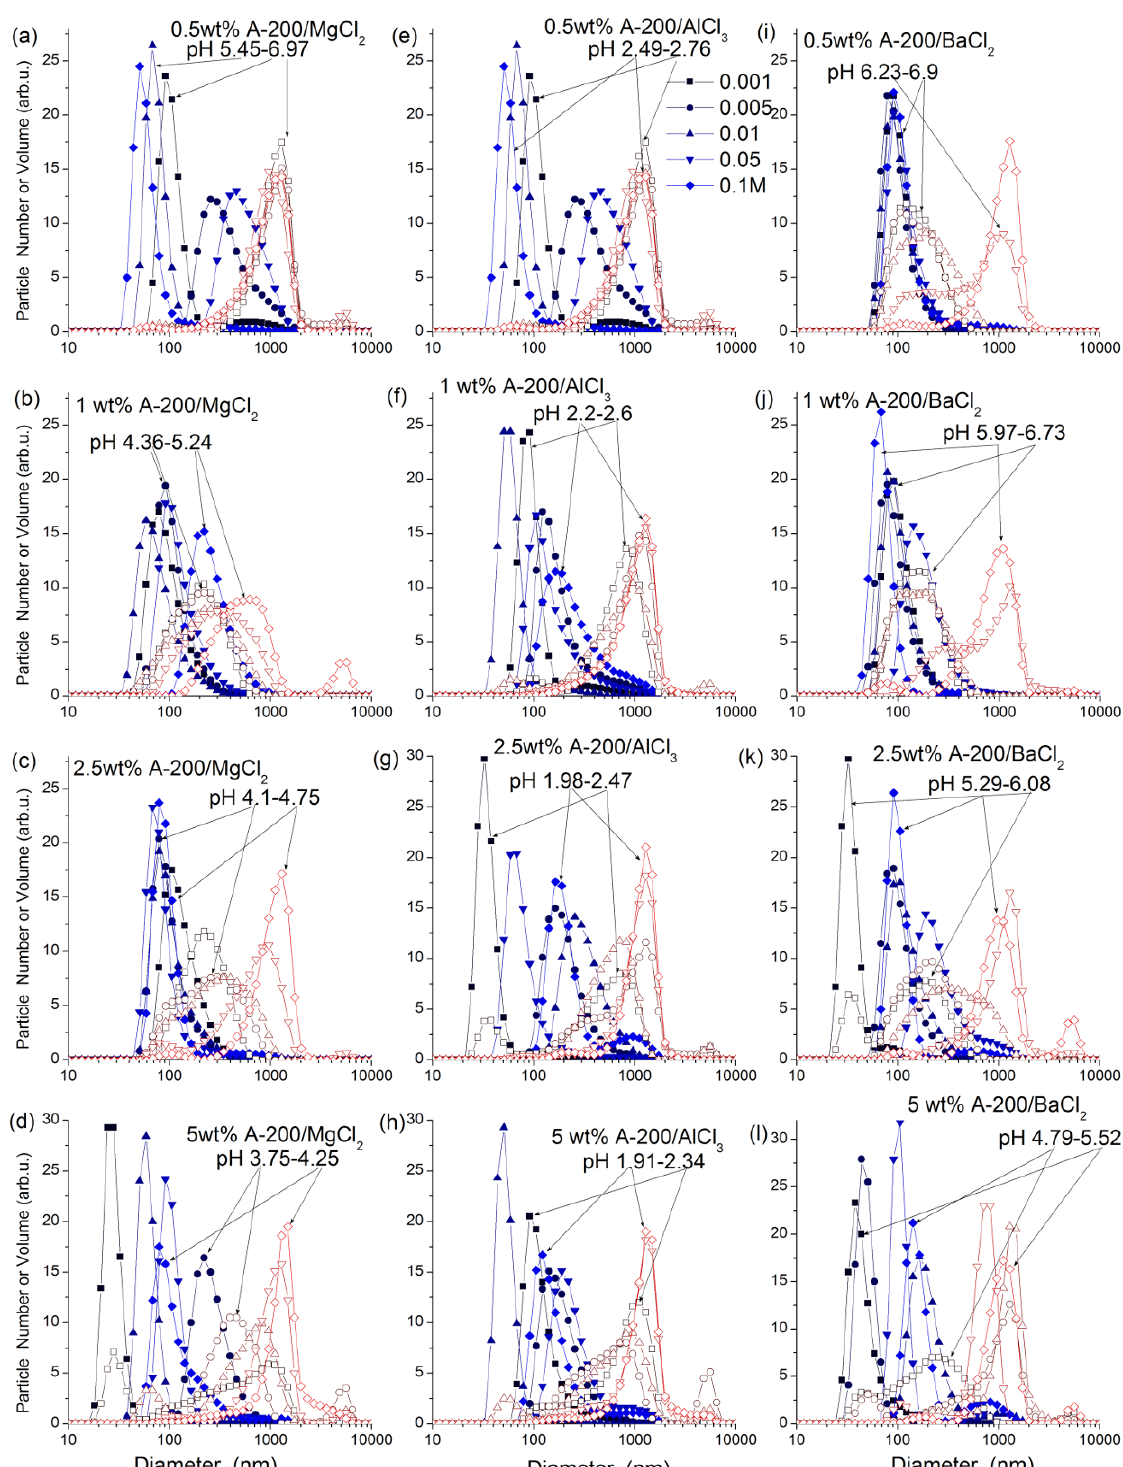
Figure 3. Particle size distributions with respect to the particle number (solid symbols) and volume (open symbols) at different content of (a-c)